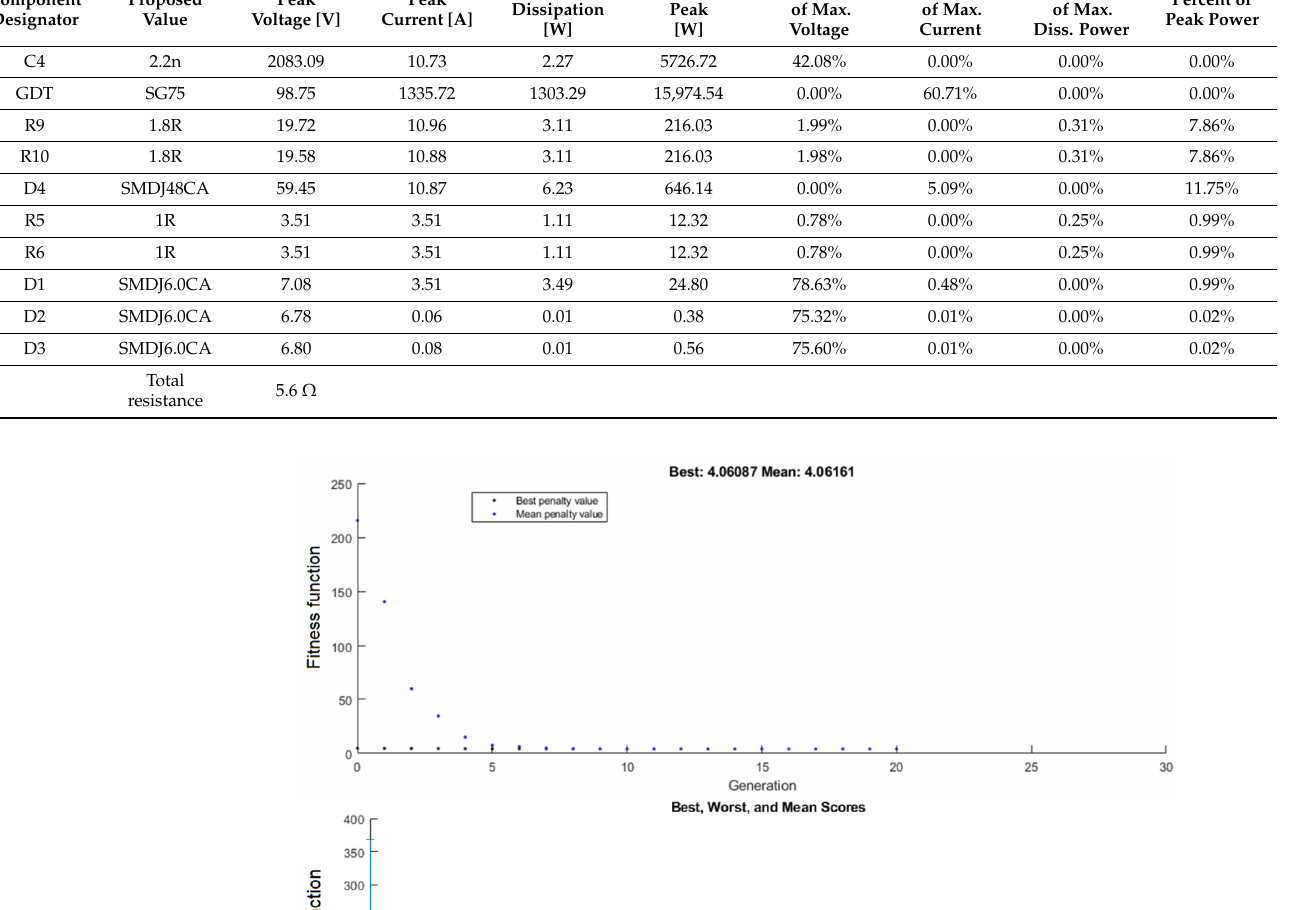
Table 4. Proposal of suboptimal components specification.